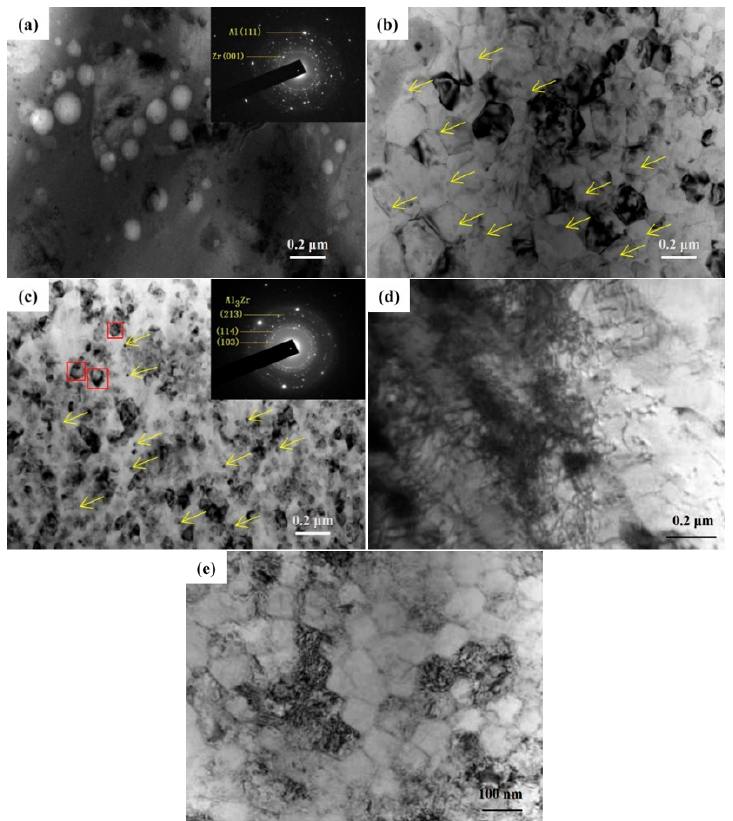
Figure 6. TEM micrographs of the alloying layer after HCPEB irradiation: ( a ) 10 pulses, ( b ) 20 pulses, ( c ) 30 pulses, and ( d – e ) high-density dislocation lines and ultra-fine grain after 30-pulsed irradiation.